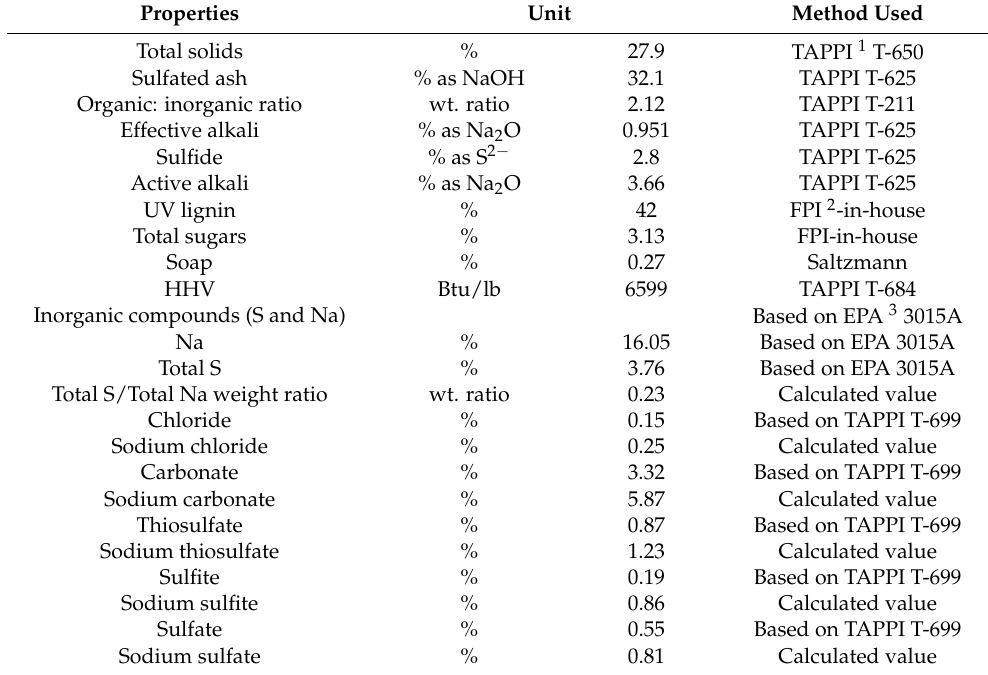
Table 1. Softwood kraft black liquor composition (oven dry basis) from Eastern Canadian mill.